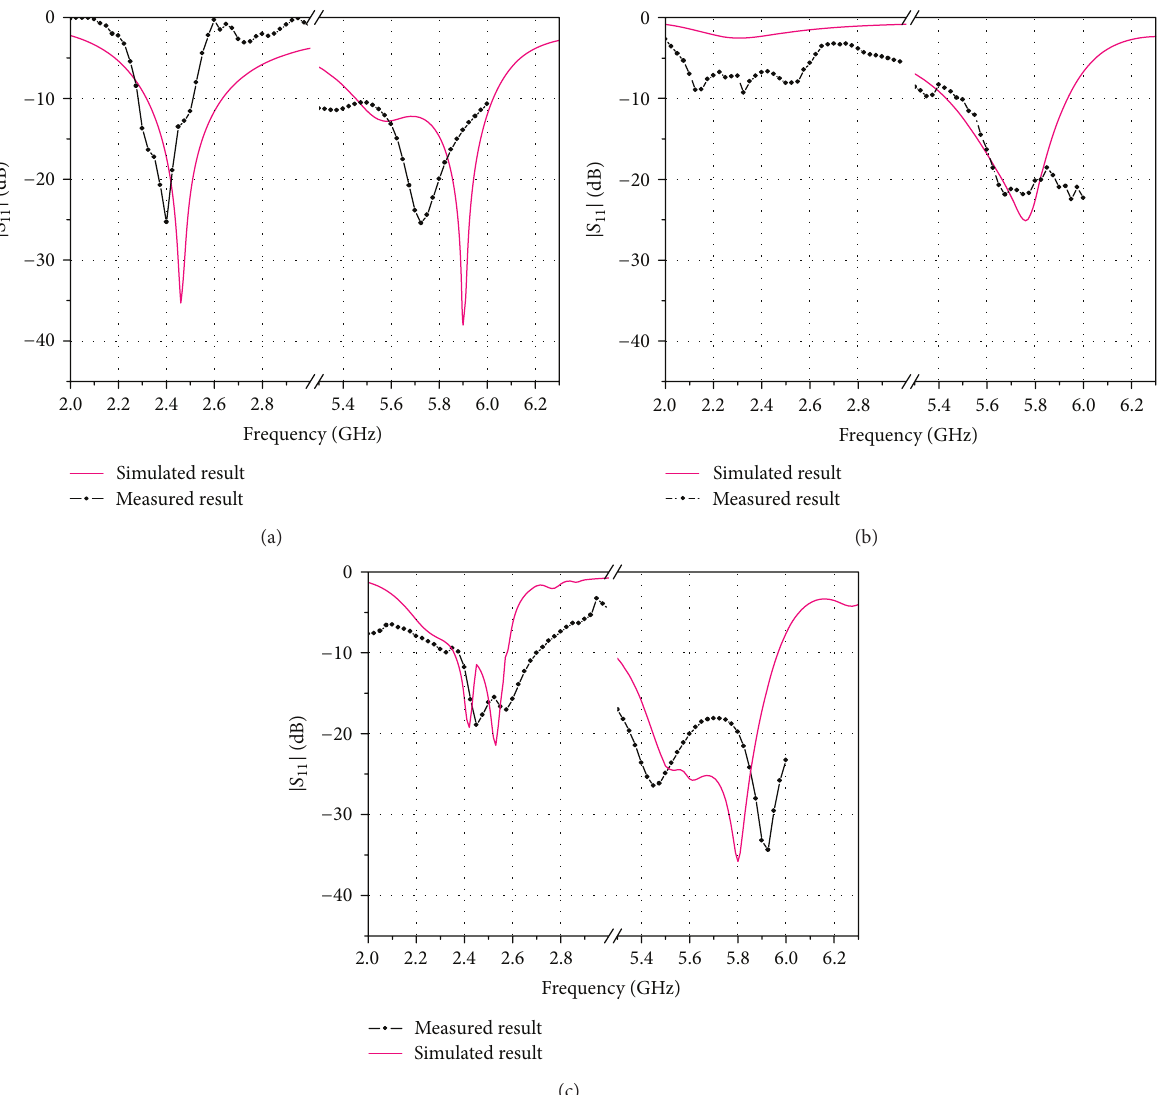
Figure 13: Measured and simulated |𝑆11| for (a) reference antenna, (b) antenna with PEC reflector, and (c) antenna with AMC reflector.